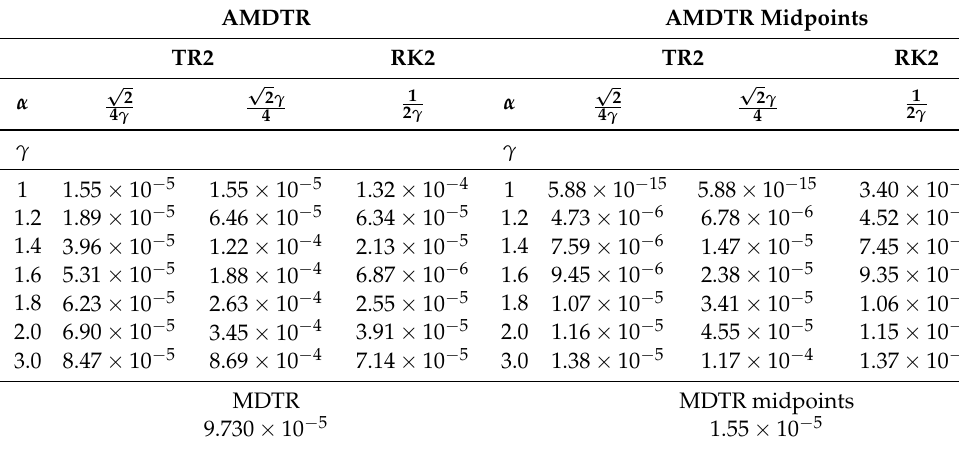
Table 2. Error in the angular momentum for the methods in the MDTR family, computed at the midpoints t n + 1/2 . As reference value, we use the one computed at t 1/2